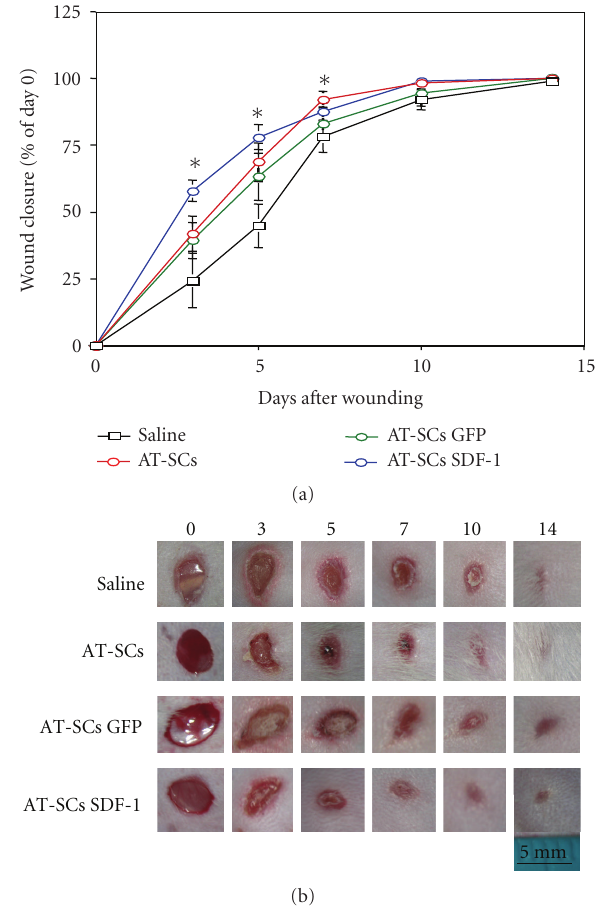
Figure 3: Wound closure in diabetic animals. E ff ect of topical administration of AT-SCs at the lesion site. Four groups of wounded diabetic mice were treated with saline solution (Saline), AT-SCs not genetically modified (AT-SCs) or AT-SCs after adenoviral-mediated gene transfer of GFP (AT-SCs GFP), and SDF-1 (AT-SCs SDF-1). At di ff erent time points after wounding, the area of the lesion was determined using image analysis. Re-epithelialization is reported as the percentage of the initial wound area (a). Representative images from an animal from each group were taken immediately after wounding (day 0) and at di ff erent time points after injury (b). Data are expressed as mean ± SEM indicated by error bars; n = 8–12 wounds for each group. Values of the AT-SCs, AT-SCs GFP, and AT-SCs SDF-1 were significantly di ff erent ( P < . 05) when compared to the saline group at the time points indicated by an asterisk. Moreover, at 3 and 5 days, wound closure was improved in AT-SCs SDF-1-treated animals in comparison with the AT-SCs GFP group ( P < .